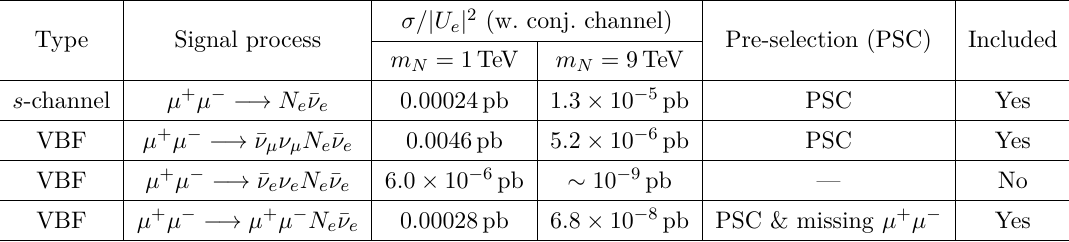
Table 7 . The signal rate for N e at 10 TeV muon collider. The cross section includes the charge conjugate